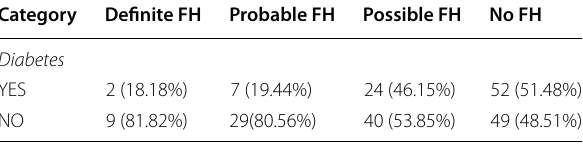
Table 4 Frequency of diabetes in FH with CAD